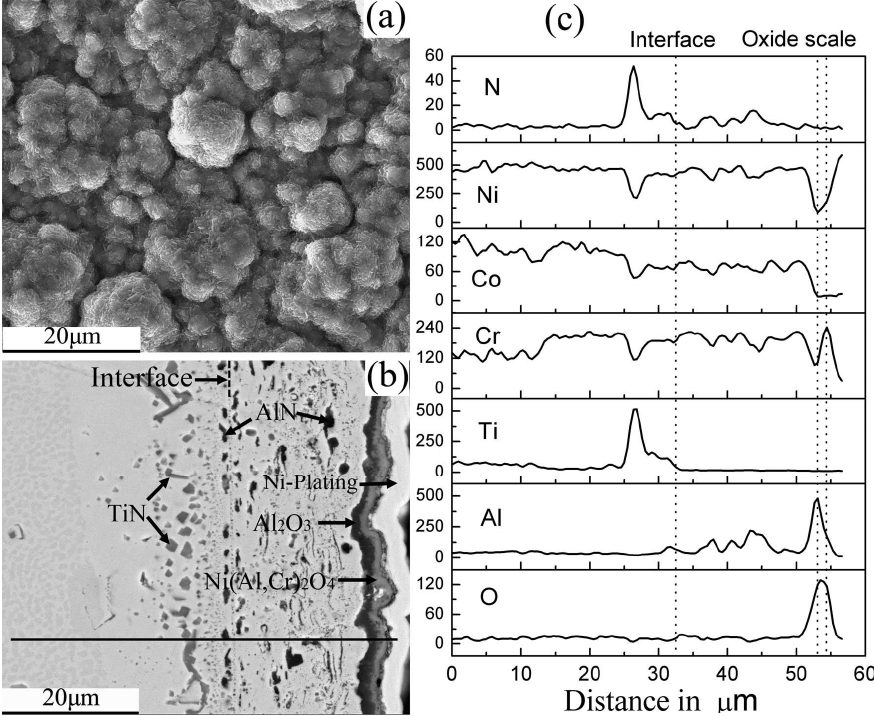
Figure 5. Surface SEM image ( a ), Cross-sectional BSE image ( b ) and the element depth profiles (( c ), analyzed by EDX) of K417/Ni+CrAlYSiN coating system after oxidation for 100 h at 1000 °C in air. The morphologies and the element depth profiles of the K417/CrN/Ni+CrAlYSiN coating system after oxidation at 1000 °C for 100 h were shown in Figure 6. Large-sized particles were formed on the surface of the composite coatings (Figure 6a); however, nei- ther cracking nor spallation of the TGO was detected. A thermally-grown oxide (TGO) scale about 2.9 μ m was formed on the surface (Figure 6b). Combined with the results an- alyzed by XRD, the cross-section image demonstrates that a double-layered dense oxide scale, inner Al 2 O 3 layer and outer mixture layer mainly dominated by Ni(Al,Cr) 2 O 4 , formed on K417/CrN/Ni+CrAlYSiN coating system (Figure 6b). Similar to the K417/ Ni+CrAlYSiN coating system, hcp-AlN particles were formed within the composite coat- ing. However, no large-sized hcp-AlN particles near the coating/substrate interface were observed. The CrN diffusion barrier disappeared. Interdiffusion between the coating and the substrate was obvious. Many TiN particles were formed in the interdiffusion zone.